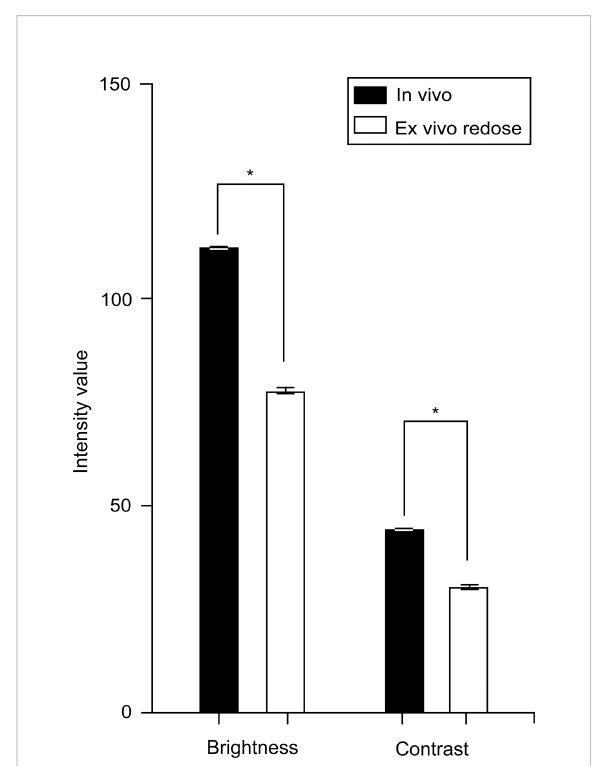
FIGURE 3 Bar plot showing the brightness and contrast of ex vivo images from patients that were redosed with fl uorescein sodium. The mean brightness (77.8 [19.9]) and contrast (30.9 [7.5]) are inferior to those from the in vivo study. Values are reported in optical density units de fi ned by Fiji software. Asterisk indicates p < 0.001. Used with permission from Barrow Neurological Institute, Phoenix, Arizona.